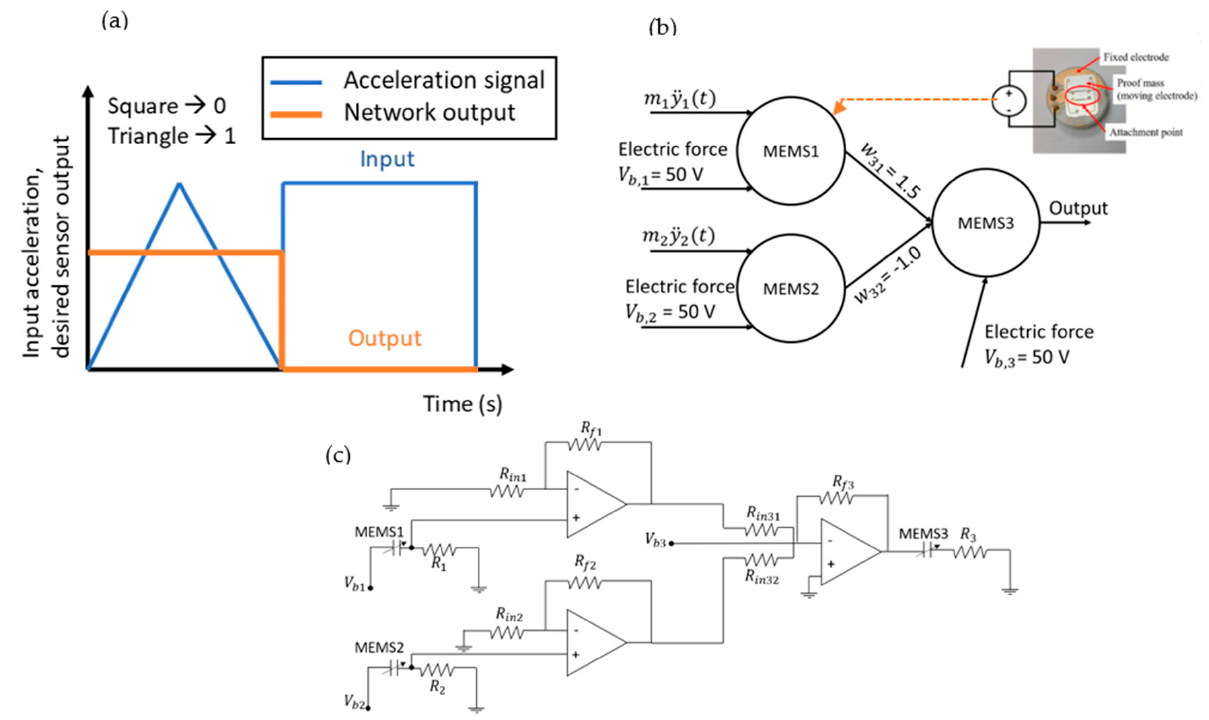
Figure 6. Classification task considered in this work. ( a ) Visualization of the binary classification problem. ( b ) MEMS network used for classification. The network is composed of three identical devices. Two devices receive an input acceler-ation signal and one device performs classification. ( c ) A connection circuit for the MEMS